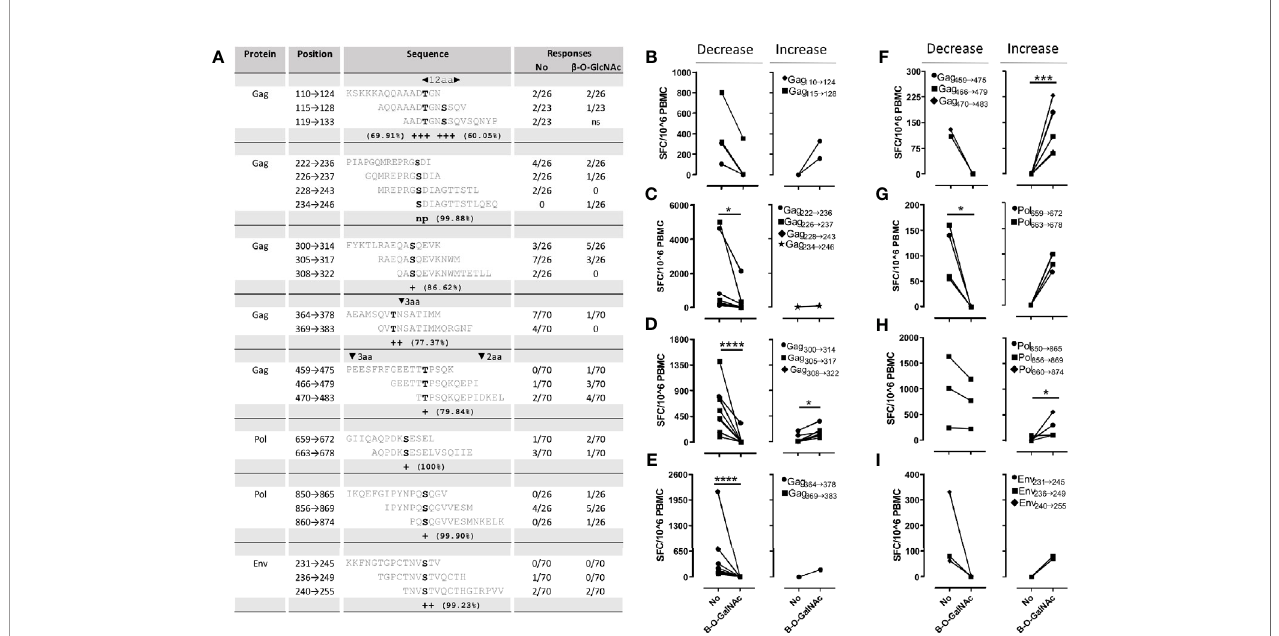
FIGURE 2 | INF g -ELISPOT screening with b - O -GlcNAc OLP and its non-glycosylated counterparts. (A) Frequency of responders to OLP with and without glycosylation modi fi cation. Presence of insertions or deletions is indicated in upper grey bars. Prediction of O- b -glycosylated positions by YingOYang is based on the server output (http://www.cbs.dtu.dk/services/). The frequency of the potential glycosylation sites in the HIV sequence database alignments is also indicated. (B – I) Magnitude of the response to b - O -glycosylated peptides and their non-glycosylated equivalents. OLP covering the same region are shown in the same graph, individuals who decreased their OLP response to the glycosylated OLP version are shown in the left panels while individuals with increased responses to the glycosylation containing OLP are shown in the right hand panels. Mann-Whitney p values are indicated by * p <0.05, ** p <0.01, *** p <0.001, **** p